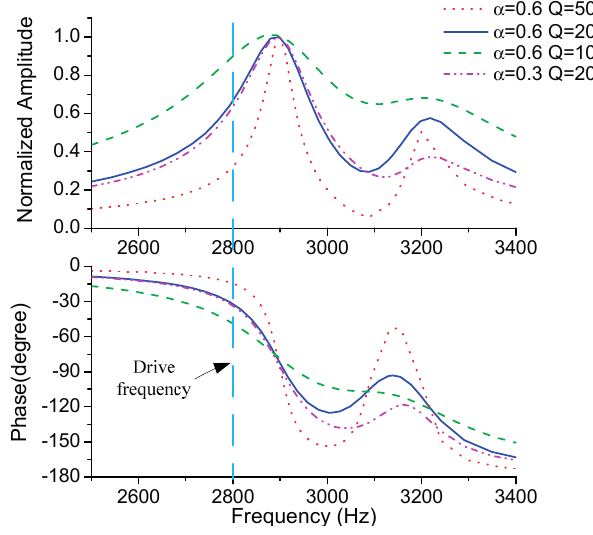
Figure 3. Frequency responses of the sense mode with different Q -factor and (cid:2009) .